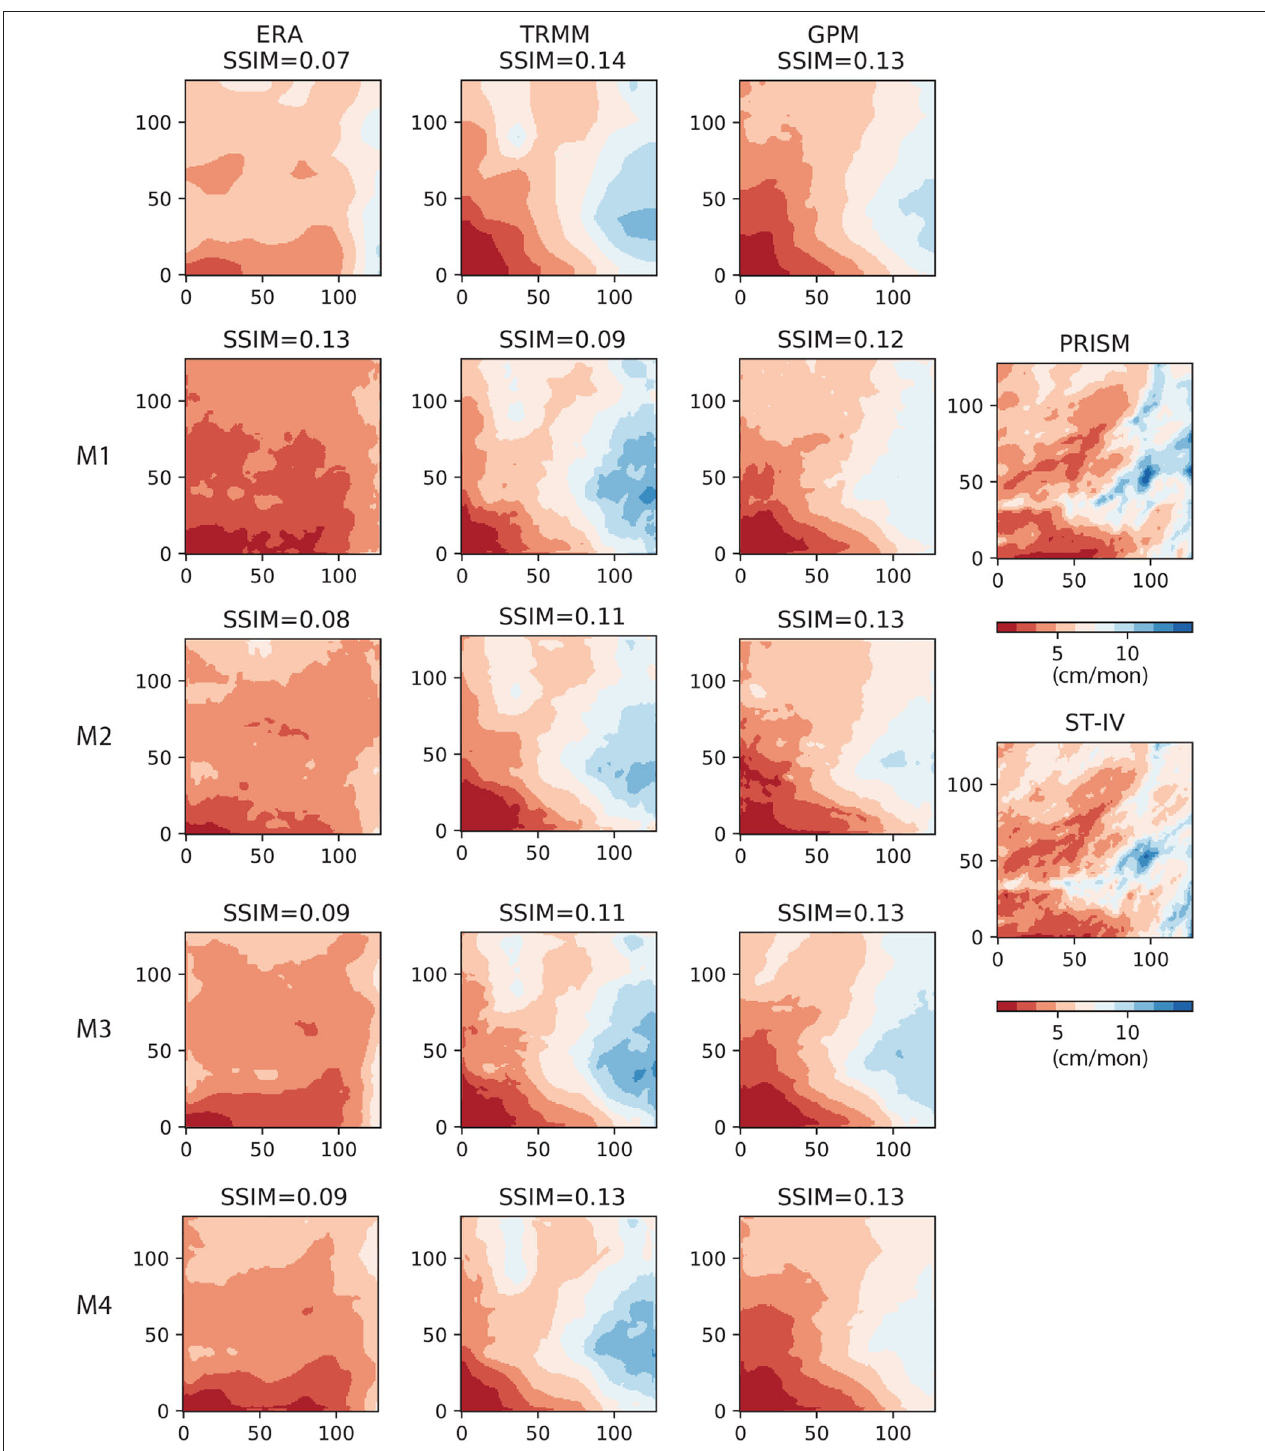
FIGURE 9 | AU-Net results on 2017/01 data (128 × 128 grid). Left column (from top to bottom) ERA5 and the corresponding M 1 − M 4 AU-Net models; 2nd column: TRMM and the corresponding AU-Net models; 3rd column: GPM and the corresponding AU-Net models; rightmost column: PRISM and the reference Stage-IV data for the same month. All subplots are scaled to the same color